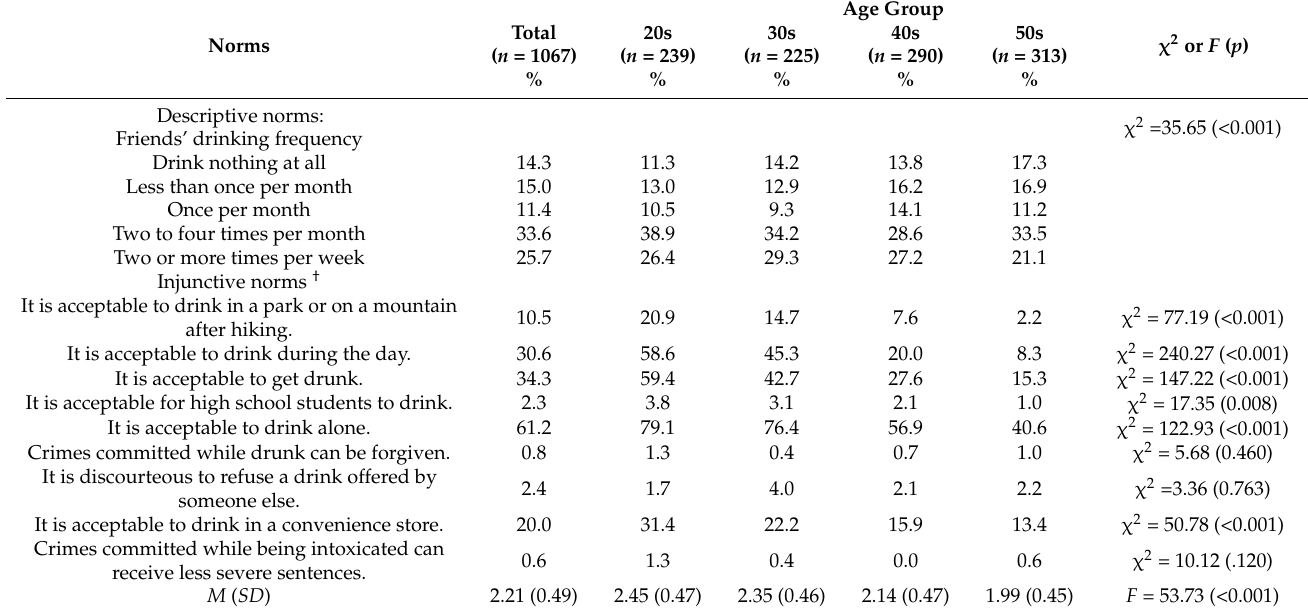
Table 2. Descriptive and injunctive norms across age groups (% of agreement, N =